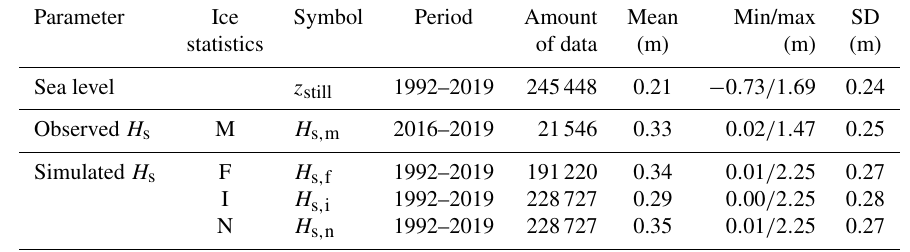
Table 1. The sea level (still water level, z still ) and significant wave height ( H s ) data sets used in this study. Parameter Ice Symbol Period Amount Mean Min/max SD statistics of data (m) (m) (m) Sea level z still 1992–2019 245448 0.21 − 0 . 73 / 1 . 69 0.24 Observed H s M H s , m 2016–2019 21546 0.33 0 . 02 / 1 . 47 0.25 Simulated H s F H s , f 1992–2019 191220 0.34 0 . 01 / 2 . 25 0.27 I H s , i 1992–2019 228727 0.29 0 . 00 / 2 . 25 0.28 N H s , n 1992–2019 228727 0.35 0 . 01 / 2 . 25